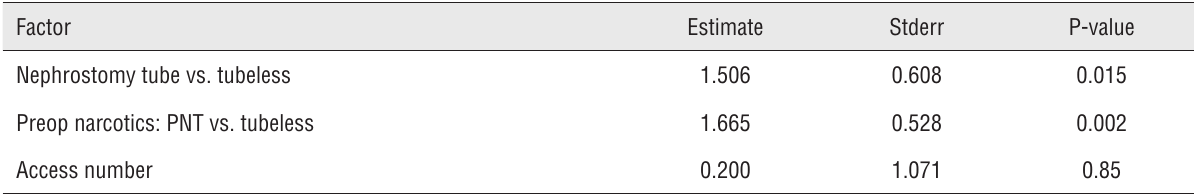
Table 4 - Multi-variable association between pain score and PNT, adjusting for pre-op. narcotics, and stone location. Factor